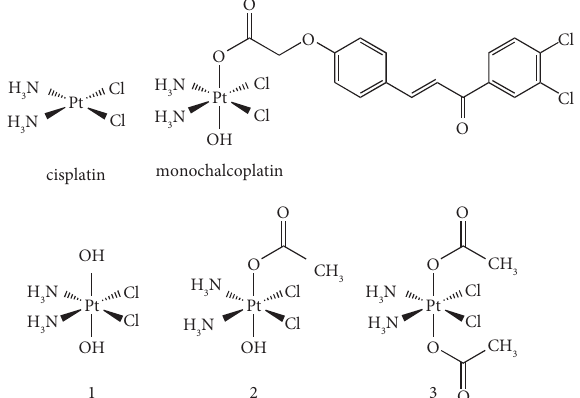
Figure 1: Chemical structures of the platinum complexes studied (cisplatin and 1 – 3 ) and